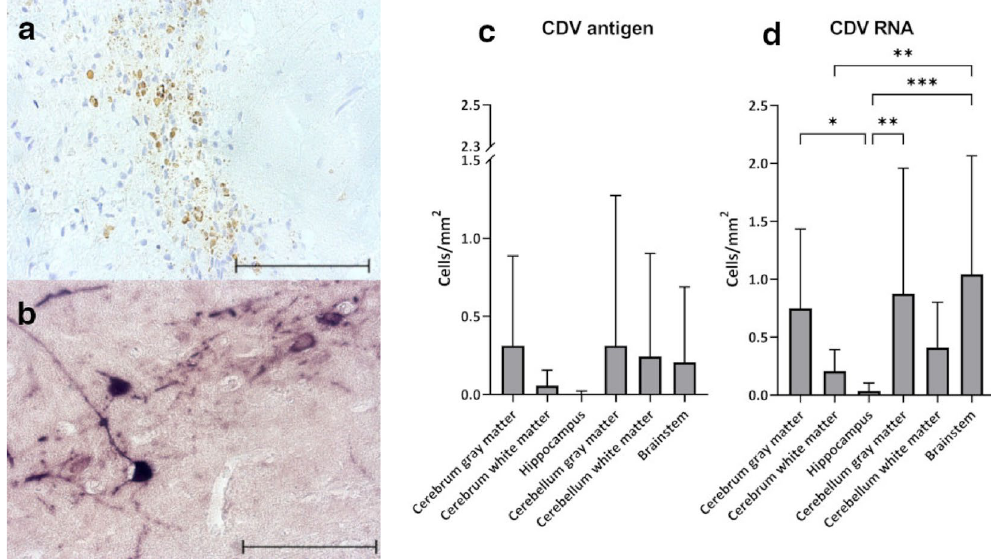
Figure 2. CDV antigen and RNA distribution in the brain of infected foxes. ( a ) CDV N antigen, immunohistochemistry, cerebellar white matter ( b ) CDV RNA, in situ hybridization, cerebrum. ( c ) Number of CDV N antigen-positive cells in different brain regions. ( d ) Number of CDV RNA-positive cells in different brain regions. (c, d) Bars display mean values and standard deviations. Asterisks indicate statistical significance levels, * ≤ 0.05, ** ≤ 0.01, *** ≤ 0.001. Scale bars = 100 µM.